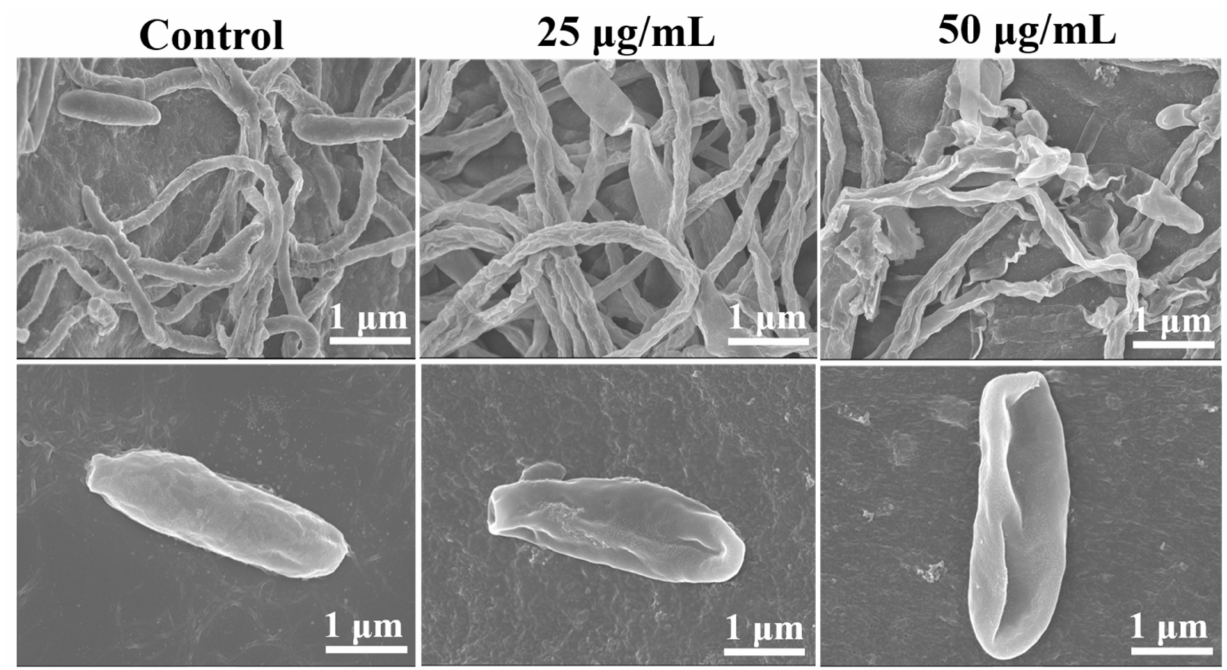
Figure 3. Effects of 25 and 50 µ g/mL iturin A on hyphal and spore morphology of F. oxysporum revealed by scanning electron